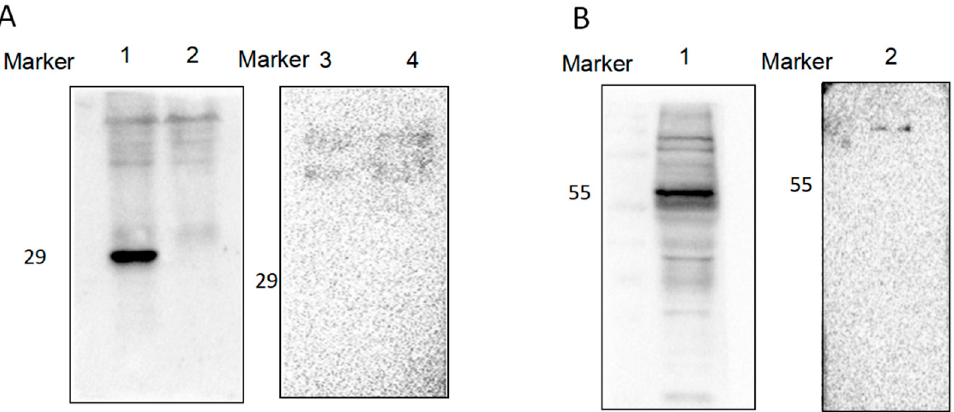
Figure 4. Specificity of the GRA3 PcAb evaluated by Western blotting. ( A ) The GRA3 PcAb reactivity against GRA3 proteins in N2a cells infecting the T. gondii ME49 strain. Lane M: protein marker;